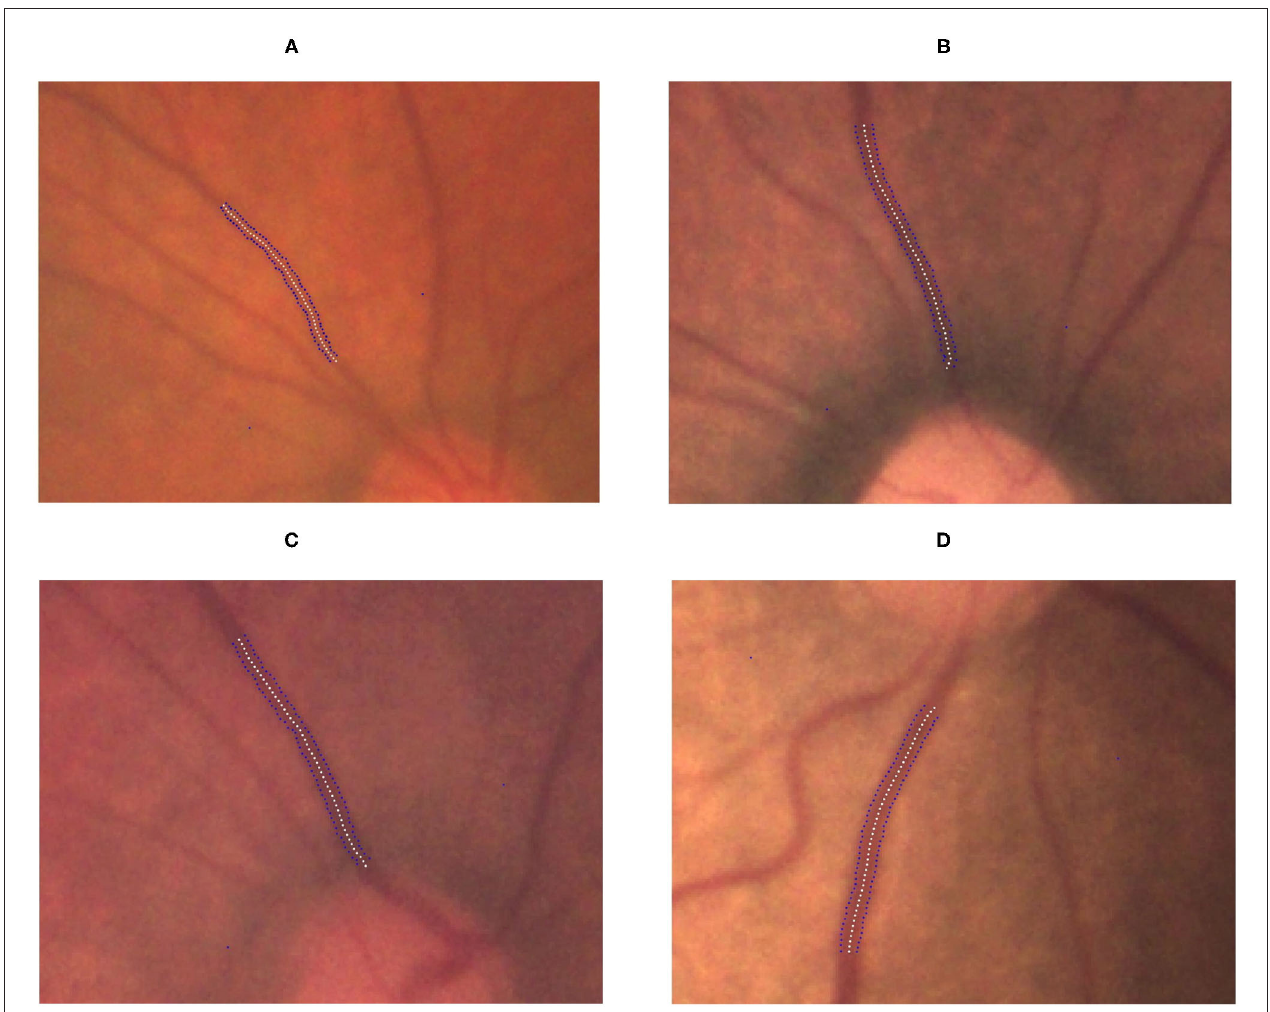
FIGURE 5 | Gradual increment in TVW from no ROP to stage 3 ROP. (A) No-ROP, (B) stage 1 ROP, (C) stage 2 ROP, and (D) stage 3 ROP groups, with widths 5.14, 5.45, 5.76, and 6.99 pixels, respectively. The white dotted curve indicates the centerline of the vessel, and the blue dotted curves indicate the borderlines of the